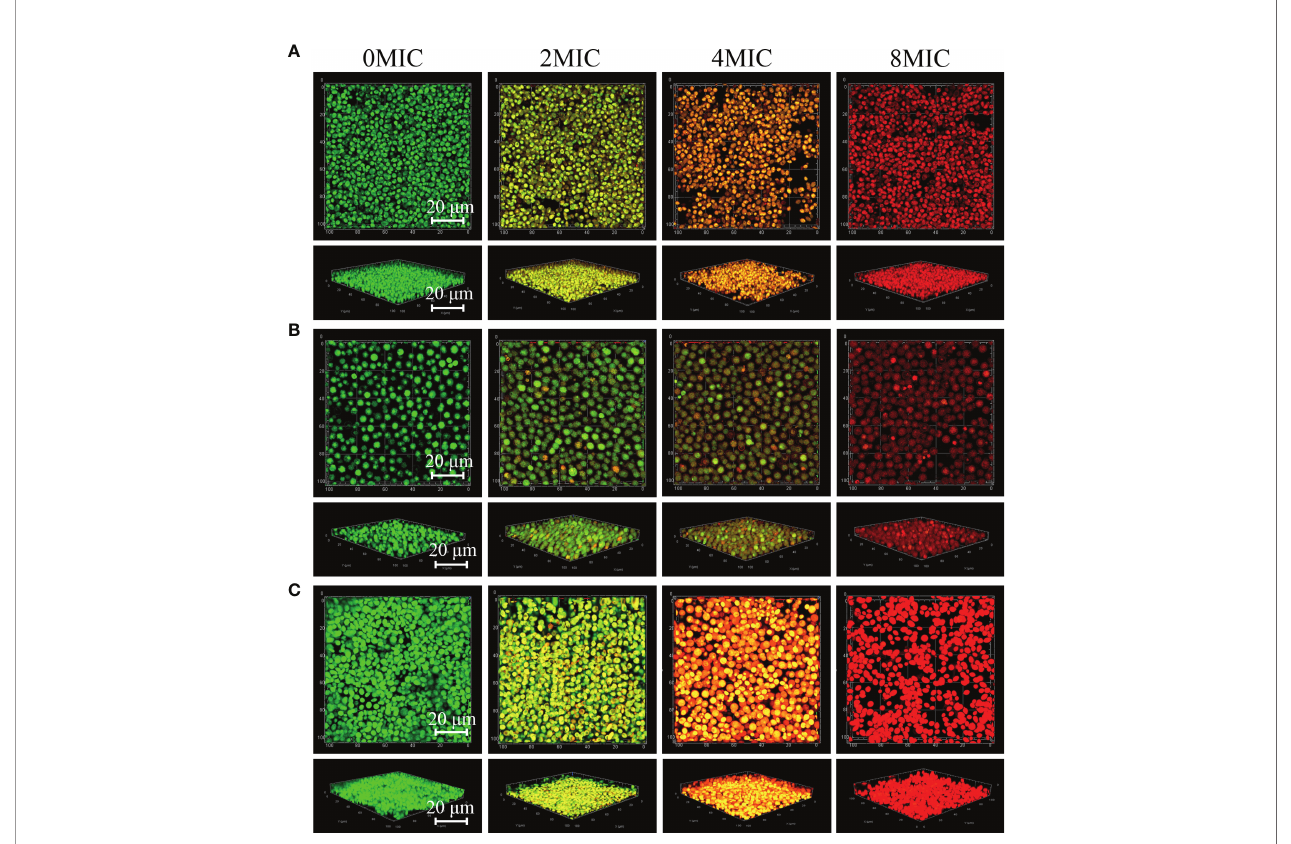
FIGURE 7 | 2D and 3D micrographs of viable and damaged bio fi lm cells of C. albicans SC5314 and C. neoformans H99 mono- and dual-species using confocal laser scanning microscope. C. albicans SC5314 (A) , C. neoformans H99 (B) , and dual-species (C) bio fi lm cells were treated with paeonol for 6 h at 0, 2 MIC, 4 MIC, and 8 MIC, and images were captured using a confocal laser scanning microscope in combination with SYTO 9 and propidium iodide. Viable and damaged bio fi lm cells emitted green and red fl uorescence, respectively. Scale bars represent 20 m